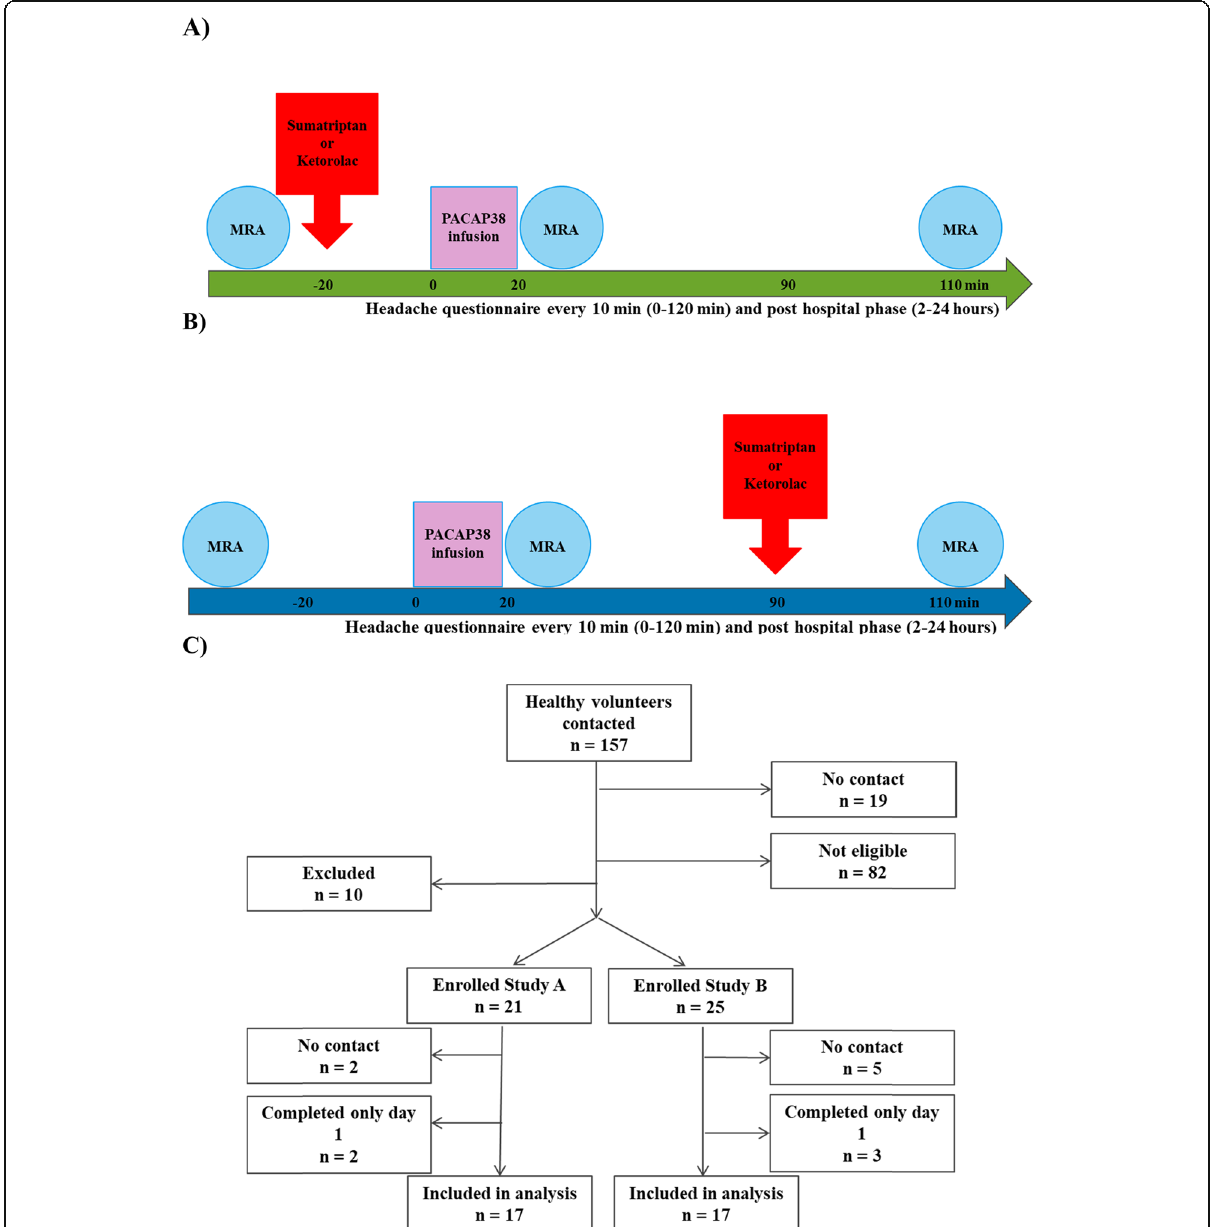
Fig. 1 a Pre-treatment study design. b Post-treatment study design. c Recruitment flow chart. All participants took part in each group in two experimental days separated by one